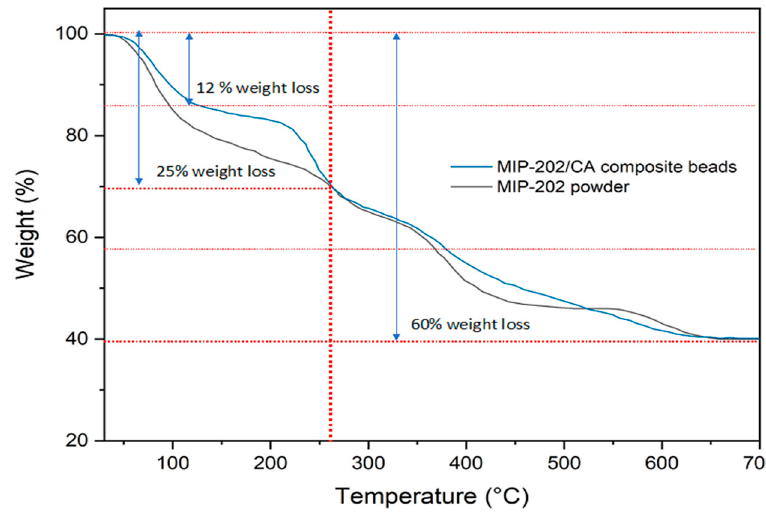
Figure 5. TGAs of MIP-202 powder (black), and MIP-202/CA composite beads (blue).